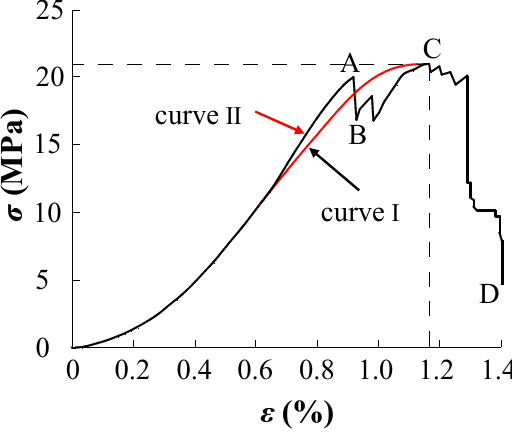
Figure 3. Comparative analysis of stress–strain curves for coal samples.